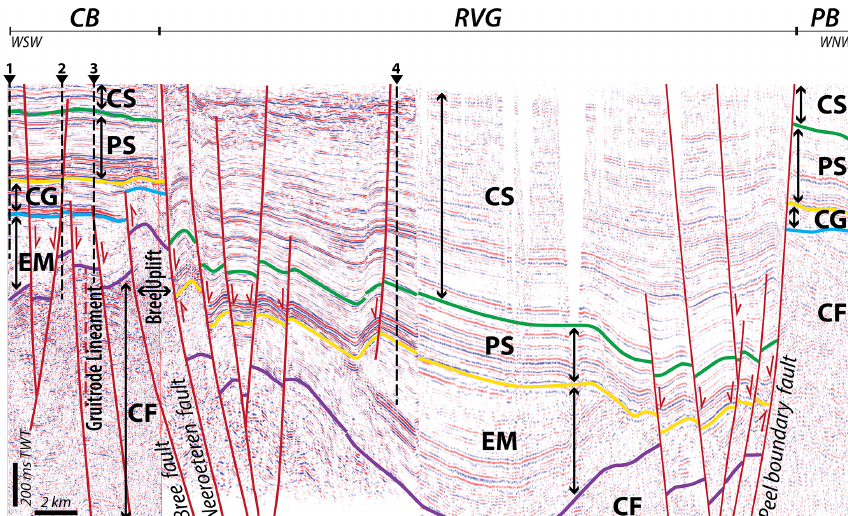
Figure 3. Composite seismic section (constructed from three seismic lines) from the Campine Block (CB) in the west, across the Roer Valley graben (RVG) in the center up to the Peel Block in the east. The location of this section is shown in Fig. 5. Note the presence of thick early to middle Mesozoic strata but absence of the Chalk Group within the RVG. The western part of this section extends across the southern domain of this study and highlights the intersection with the latest Carboniferous Gruitrode Lineament. CF: Carboniferous strata; CG: Chalk Group; CS: Cenozoic syn-rift strata; EM: early and middle Mesozoic strata; GL: axis of the Gruitrode Lineament; PS: pre-rift strata. Numbers represent boreholes at or nearby the seismic lines: 1 – Meeuwen (DOV code: kb18d48w-B173 ); 2 – Gruitrode (DOV code: kb18d48w-B186 ); 3 – Bree (DOV code: kb18d48w-B193 ); 4 – Molenbeersel (DOV code: kb18d49w-B226 ).